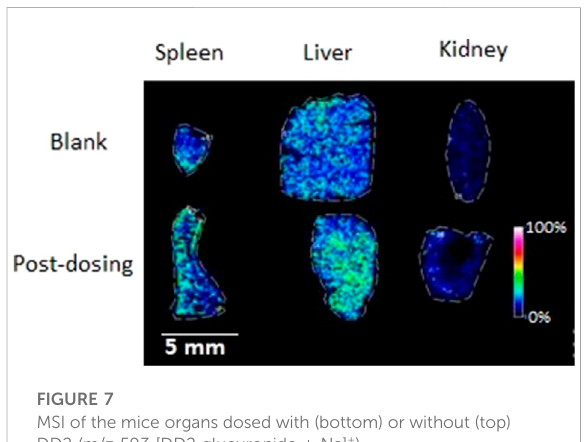
FIGURE 7 MSI of the mice organs dosed with (bottom) or without (top) DD2 (m/z 593 [DD2 glucuronide + Na] +